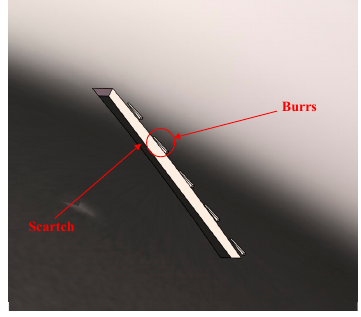
Figure 1. Schematic diagram of scratches.